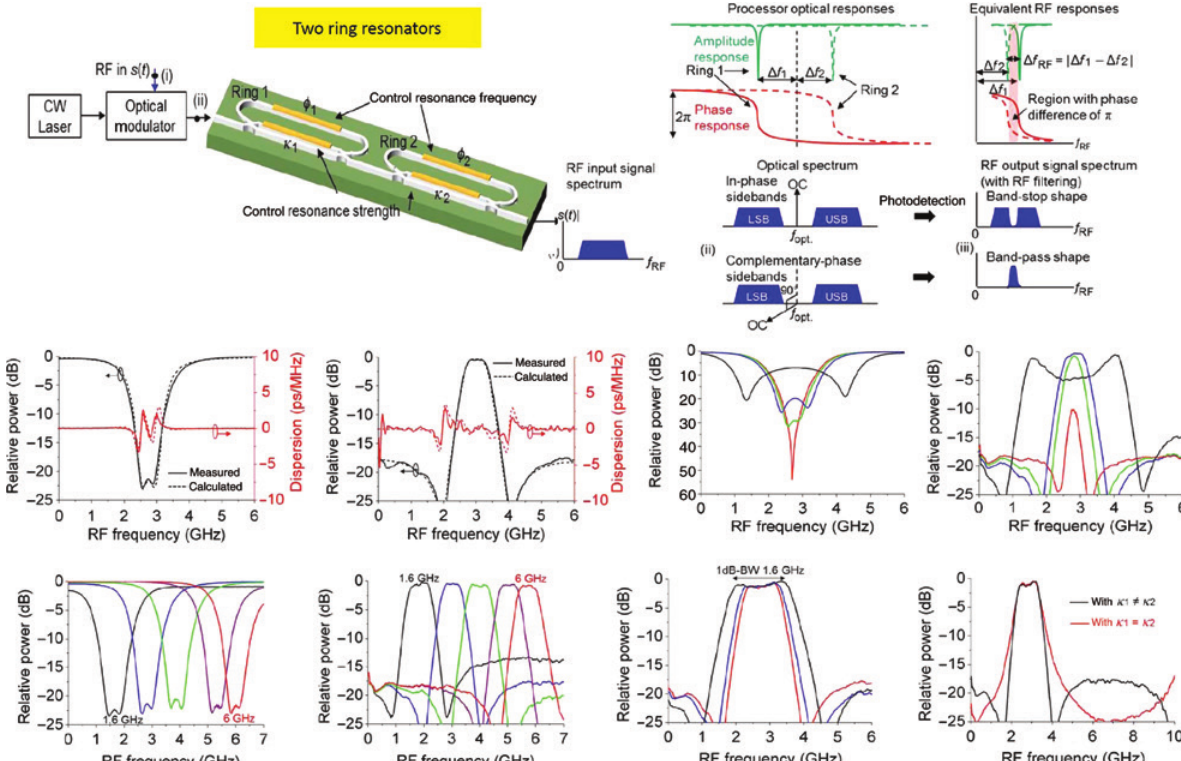
Figure 7: Microwave photonics implementations of RF filters using optical signal processor chips that comprise two ring resonators, showing the evolution toward DSP flexibility [45] (Copyright in 2015, Optical Society of